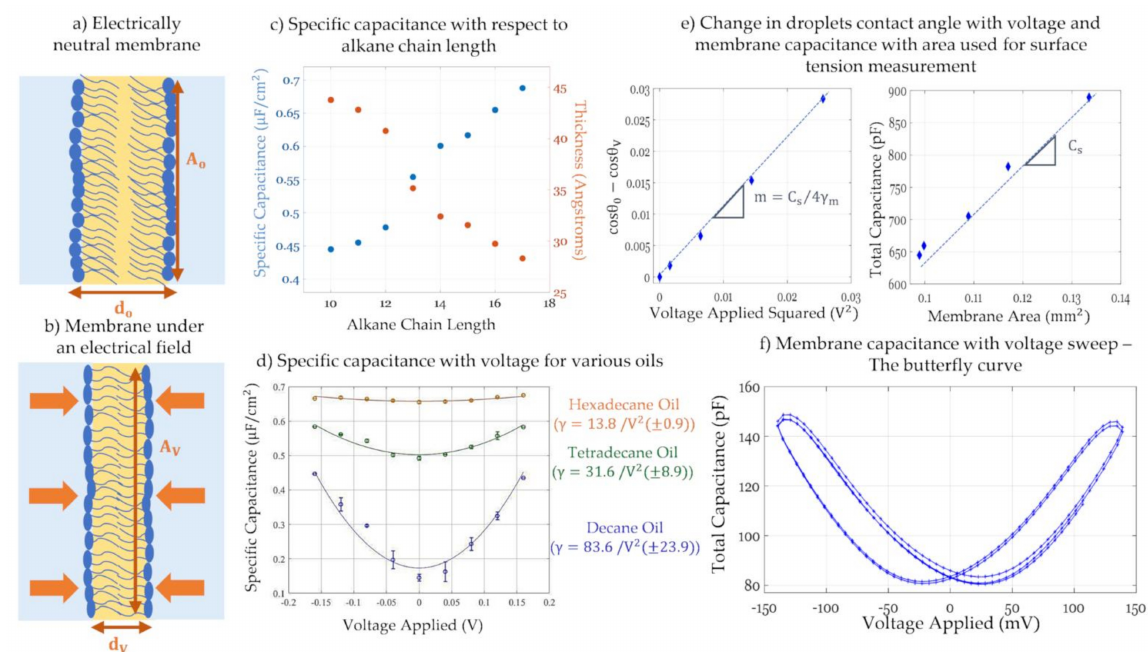
Figure 9. ( a ) With zero intramembrane electric field, the membrane is at its relaxed state with an initial geometry suitable for the system’s equilibrium. ( b ) When an electrical field is applied, the membrane undergoes electrocompression-reduction in thickness due to attractive coulomb forces and if the setup allows, electrowetting-increase in membrane area due to a reduction in surface tension. ( c ) Reproduced from “Gross, L.C., et al., Determining membrane capacitance by dynamic control of droplet interface bilayer area. Langmuir, 2011. 27(23): p. 14335-42.” Specific capacitance and thickness of membranes composed of the same phospholipids, but with varying alkane chain length shows the solvent effect on membrane properties. ( d ) Reproduced from “El-Beyrouthy, J., et al., A new approach for investigating the response of lipid membranes to electrocompression by coupling droplet mechanics and membrane biophysics. Journal of the Royal Society Interface, 2019. 16(161): p. 20190652”. Specific capacitance with respect to voltage for different solvents showing the latter’s effect on the membrane’s elasticity. ( e ) Adapted from “El-Beyrouthy, J., et al., A new approach for investigating the response of lipid membranes to electrocompression by coupling droplet mechanics and membrane biophysics. Journal of the Royal Society Interface, 2019. 16(161): p. 20190652”. The DIB set up allows for a direct in-situ measurement of monolayer surface tension by monitoring the change in droplets contact angle, and thus membrane tension, with voltage, assuming constant membrane thickness. ( f ) Changes in membrane capacitance due to a relatively fast voltage sweep leads to a butterfly shaped curve. The point of overlap indicates transmembrane potential